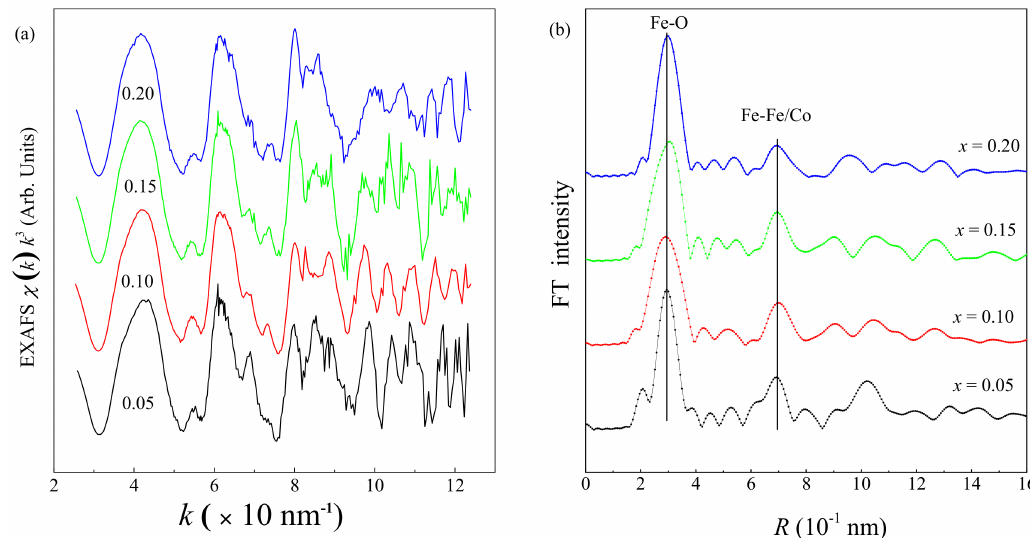
Figure 6. ( a ) Experimental XAFS spectra χ ( k ) k 3 of the Fe K-edge and ( b ) Fourier transformation of the Fe K -edge EXAFS oscillation functions for the La x Bi 1 − x Fe 0.95 Co 0.05 O 3 ( x = 0.05, 0.10, 0.15, and 0.20)